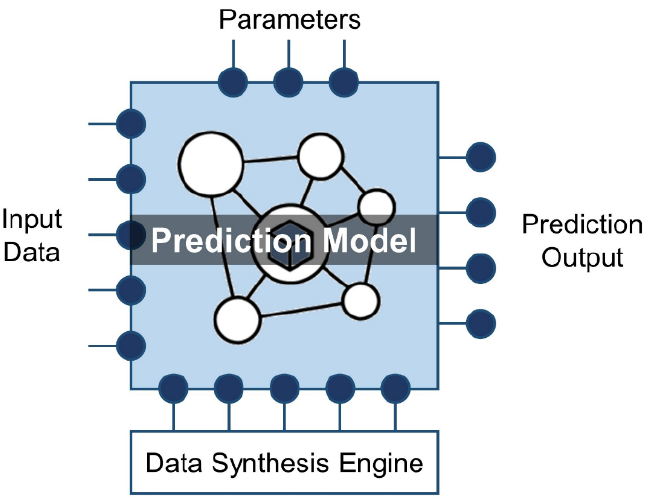
Figure 3. The architecture of Data Twin Service.